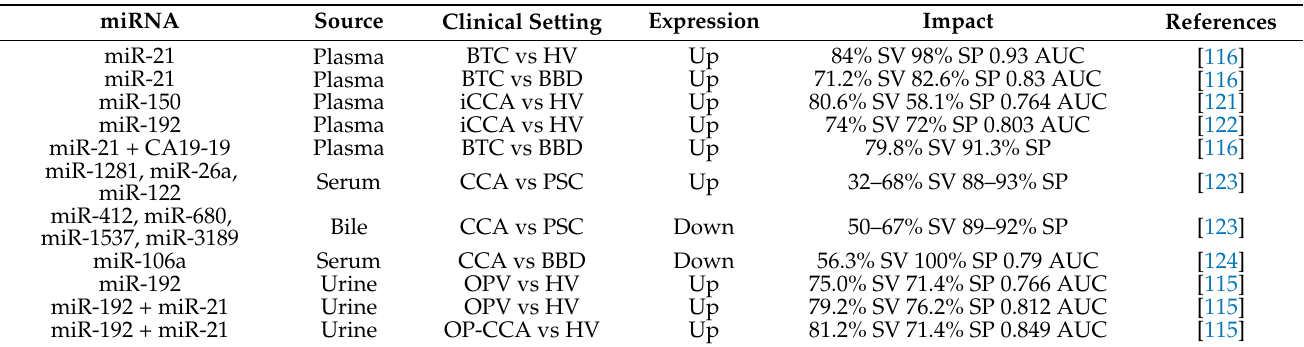
Table 3. Circulating miRNAs as potential